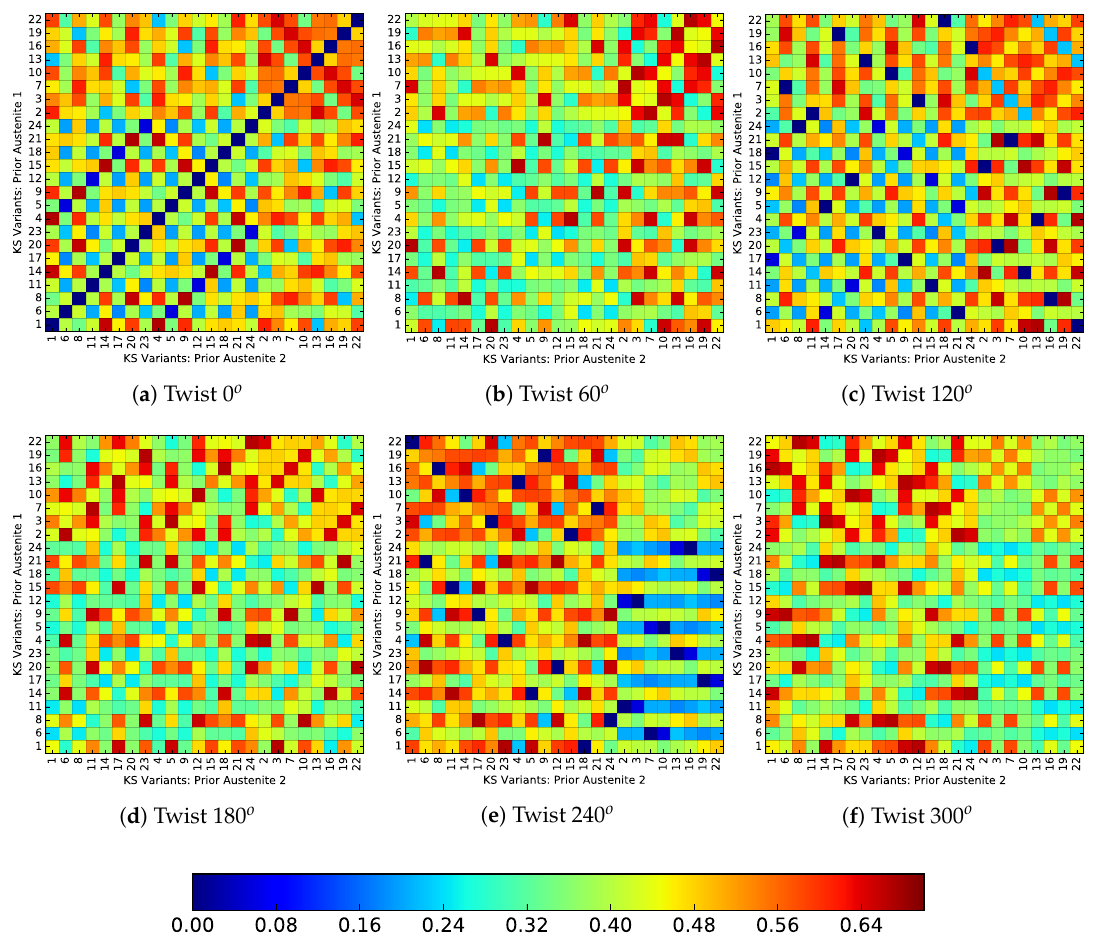
Figure 13. Transformation strain incompatibility for PAGBs with twist misorientation. The variant groups are ordered according to the Bain groups and in the order C first, then the variants of B and A (last), Table